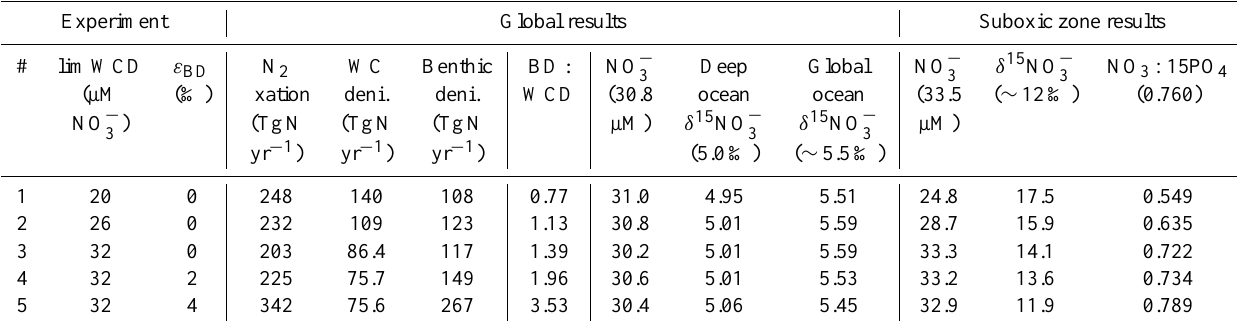
Table 2. Model sensitivity experiment results.